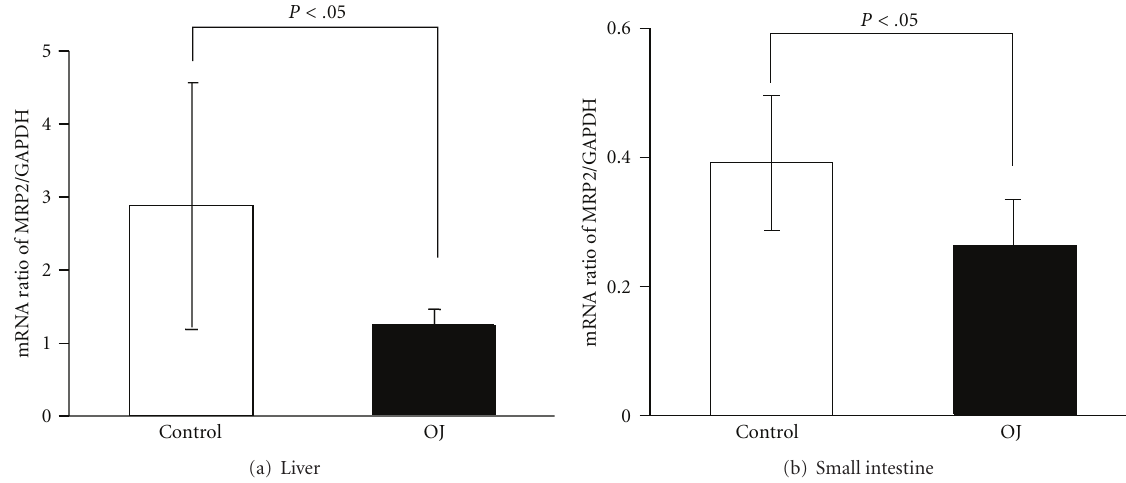
Figure 3: E ff ect of orange juice (OJ) on the expression of Mrp2 mRNA in both the liver (a) and small intestine (b) in rats. Tap water or OJ was given according to the same schedule as in Figure 1. The liver and small intestine were removed 1h after the last ingestion of OJ or tap water, respectively, and total RNA was extracted from these tissues directly with the RNAgent Total RNA Isolation System. Levels of Mrp2 mRNA were determined with real-time PCR as described in Section